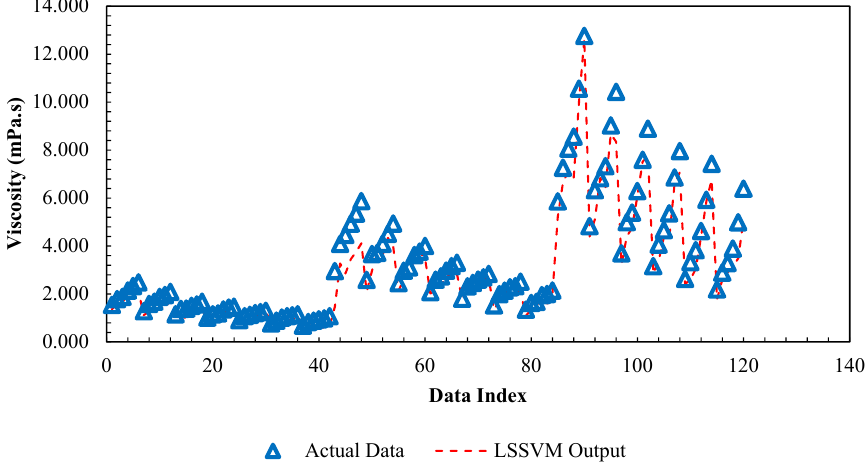
Figure 12. Comparison between actual viscosity of Fe 2 O 3 /ethylene glycol-water nanofluid and predicted values by PSO-ANN model versus relevant data index.